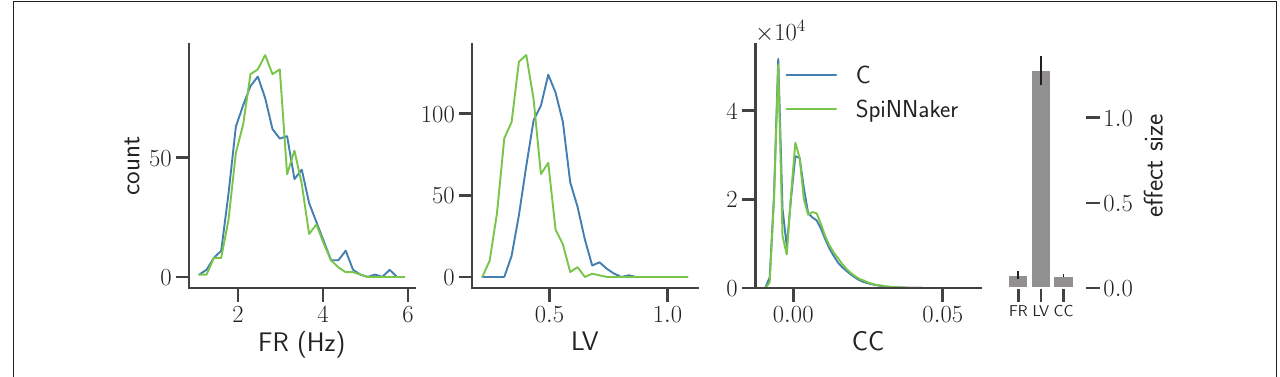
FIGURE 6 | Comparison of statistical measures after model refinement. The panels show from left to right the distributions of FR, LV, and CC of the C and SpiNNaker simulation after the first refinement of the implementations by Trensch et al. (2018) for the network state after t 5 on the right visualizes the effect size in the three statistical measures (mean and standard deviation across all five network states t 1 , t 2 , ... , t 5 ). The numerical values are FR: 0.077 0.025, LV: 1.28 0.086, and CC: 0.074 0.006 ± ± ±